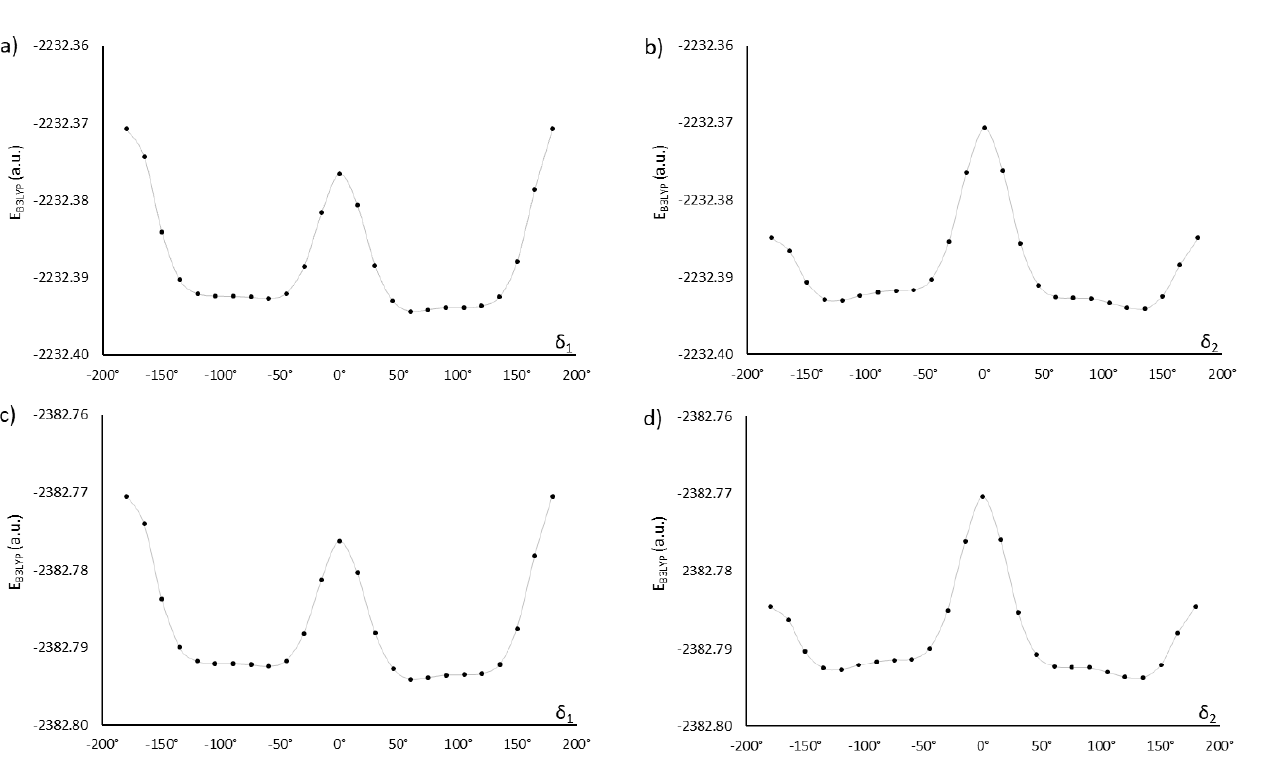
4 of 20 Figure 1. Spatial structure of the three epoxy compounds. Key dihedral angles defining the conformation ( δ i ) are indicated by circular arrows.